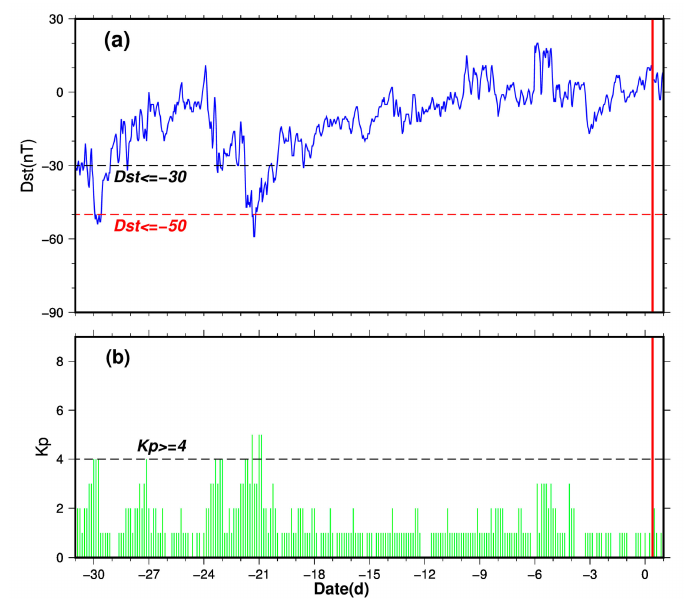
Figure 2. Geomagnetic environment variations in one month preceding to Lushan earthquake: ( a ) ring current index (Dst), and ( b ) the geomagnetic planetary (Kp)